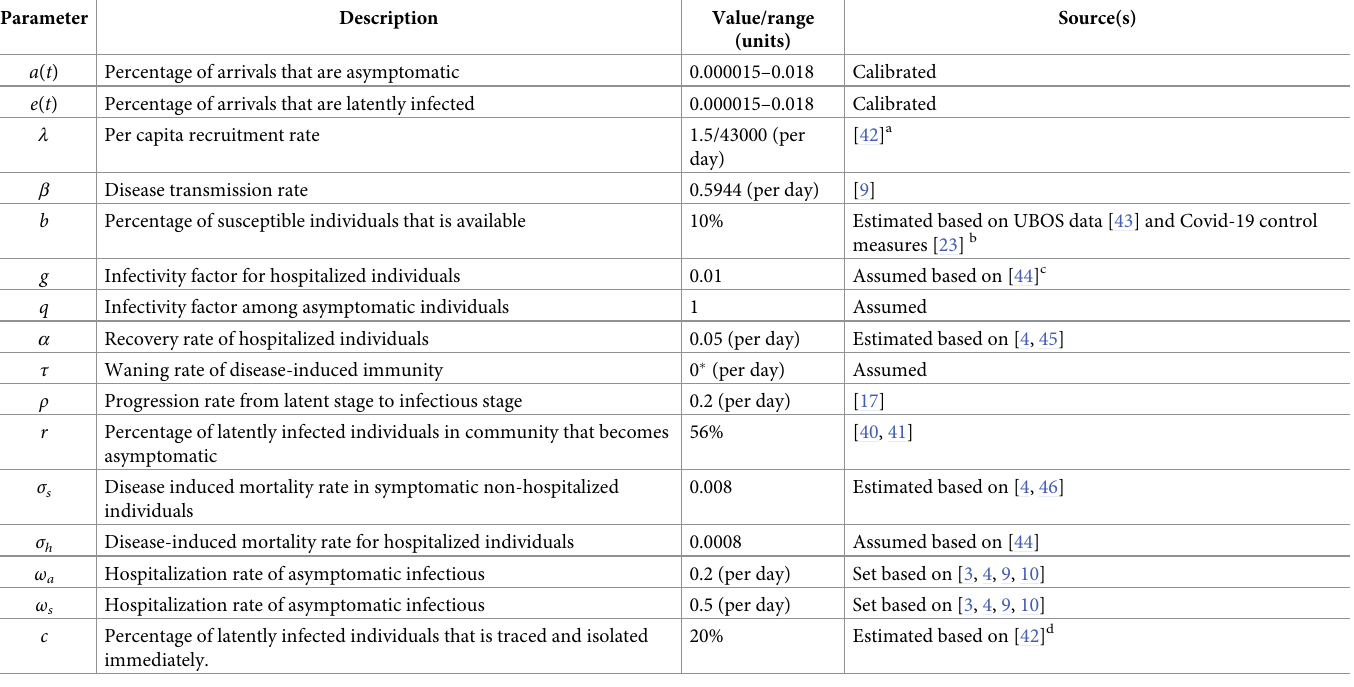
Table 1. Summary of the parameters used in the disease transmission model as obtained from WHO and MoH (Uganda) briefings and reports as well as from rele- vant literature as indicated.